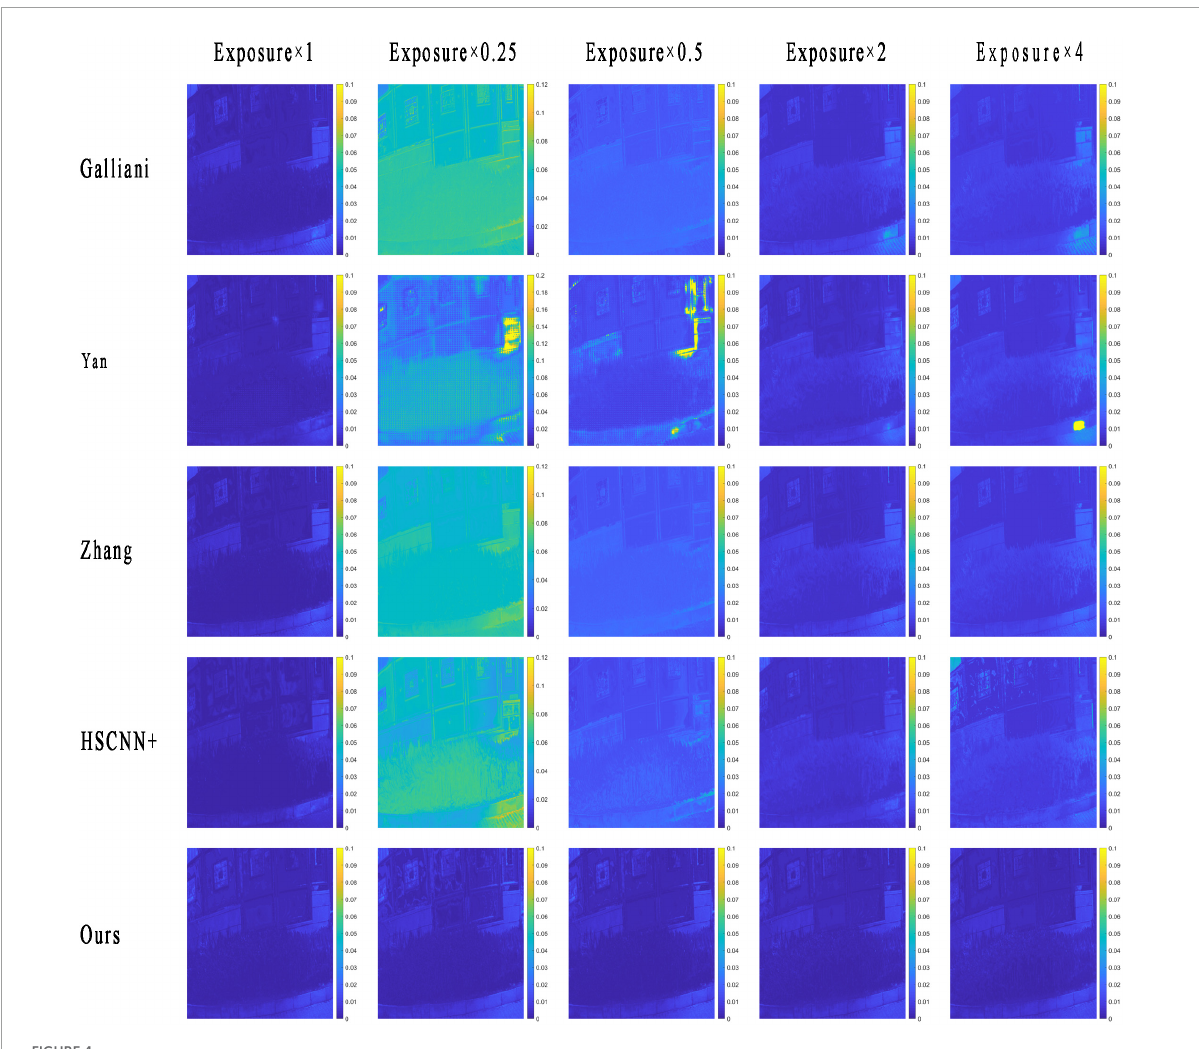
FIGURE4 The root-mean-square error (RMSE) map of a reconstructed multispectral image (RMSI) of different methods under different tested exposure levels. The photos appearing in these figures are chosen from the public multispectral dataset from the NTIRE challenges